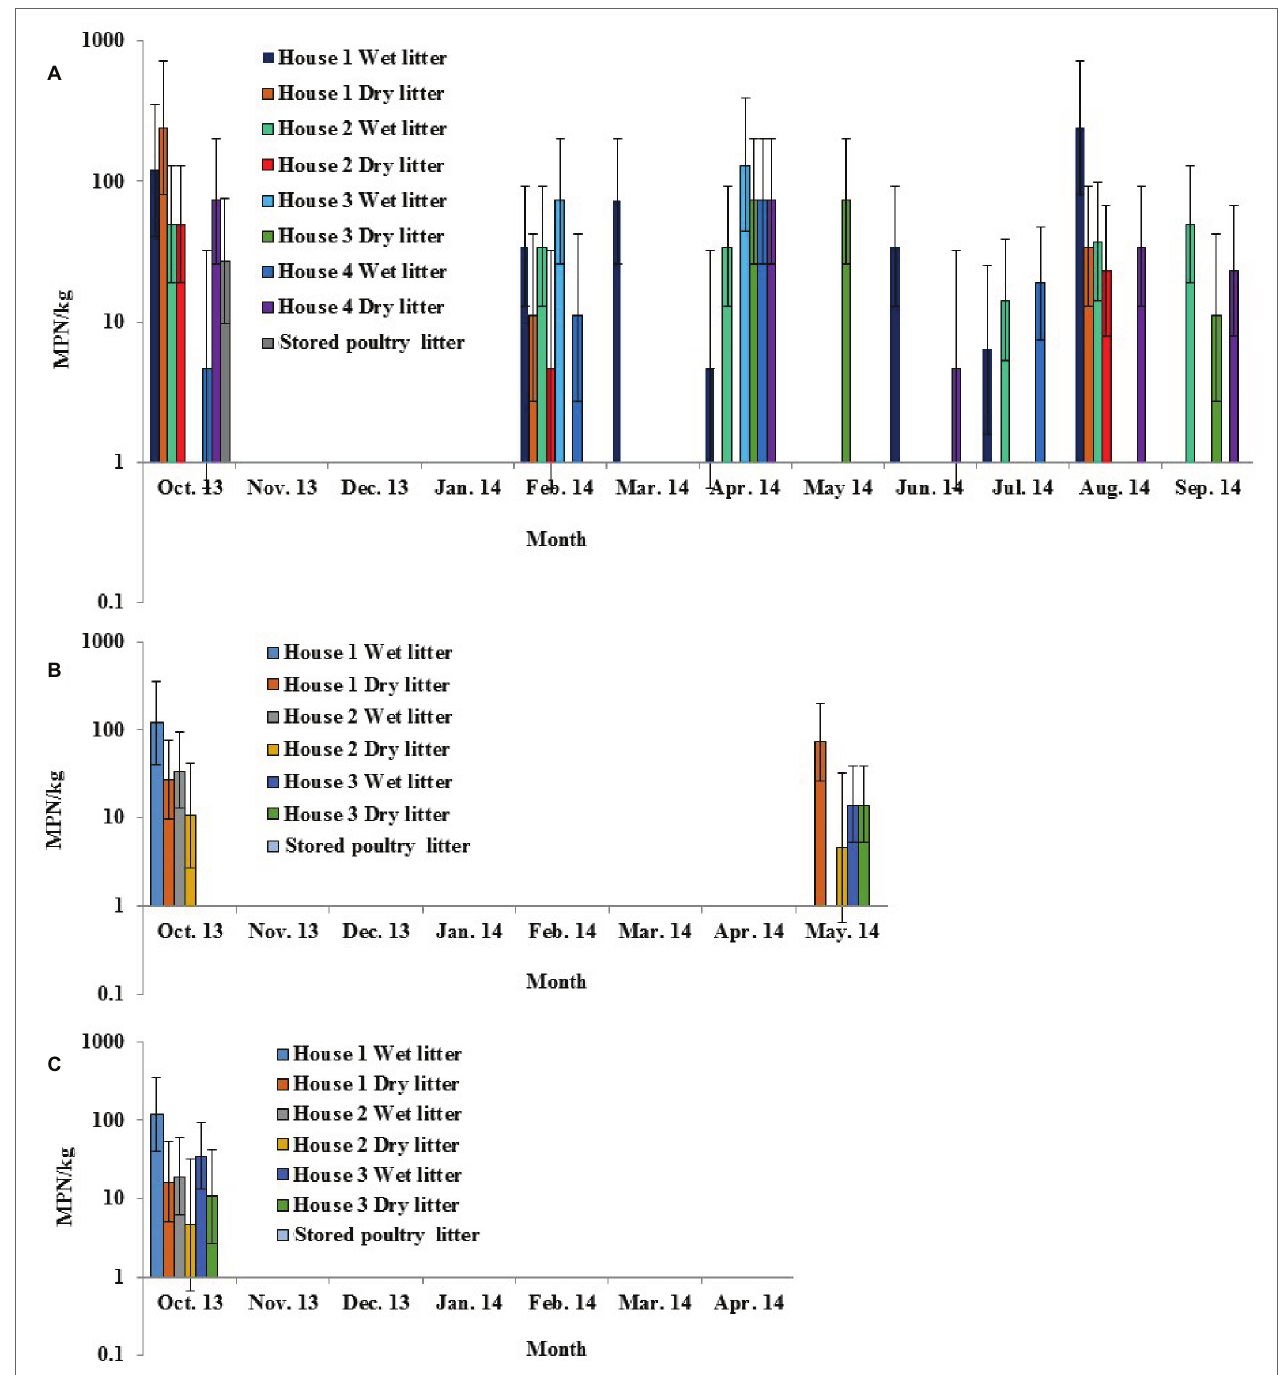
FIGURE 4 | Prevalence and MPN values of S. enterica in wet, dry, and stored poultry litter samples collected from multiple chicken houses and stacking sheds at commercial broiler Farm 1 (A) , Farm 2 (B) , and Farm 3 (C) on the ESV.